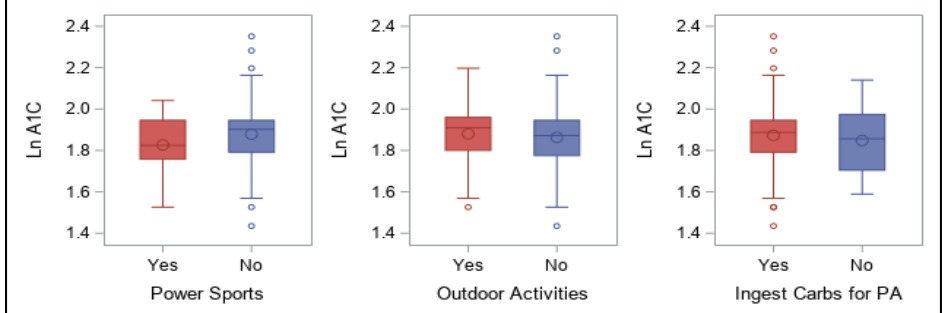
Figure 7. Participation in power sports and outdoor activities and ingestion of carbohydrates for physical activity and association with log A1C values.